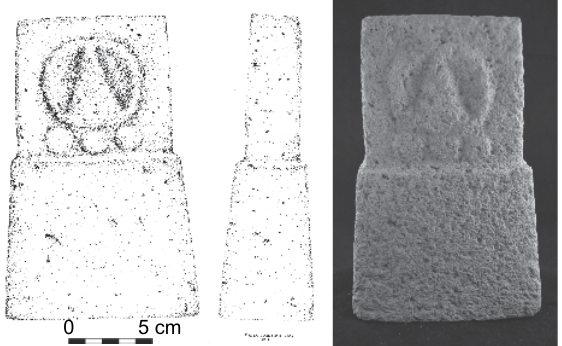
Fig. 10 Teotihuacan carved stone with glyph from Plaza of the Columns (Photograph by David M. Carballo, illustrations by Pedro Cahuantzi